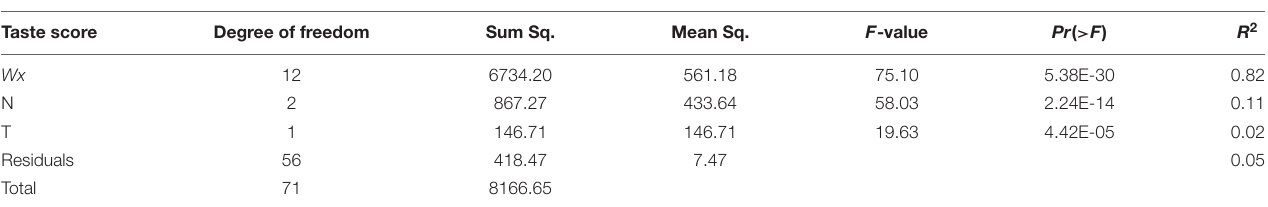
FIGURE 4 | Effects of temperature on appearance quality and other quality traits. (A) Grain appearance of Nip- Wx lv , Nip- Wx a , Nip- Wx in , Nip- Wx b , Nip- Wx mp , Nip- wx at high (HT) and normal (LT) temperatures. The mean effects of temperature on (B) taste score; (C–H) viscosity properties; (I) CD; (J) CR; (K) transparency; (L) AC; (M) PC; (N) SLCs; and (O) NSLCs. TABLE 2 | Three-way ANOVA on rice taste